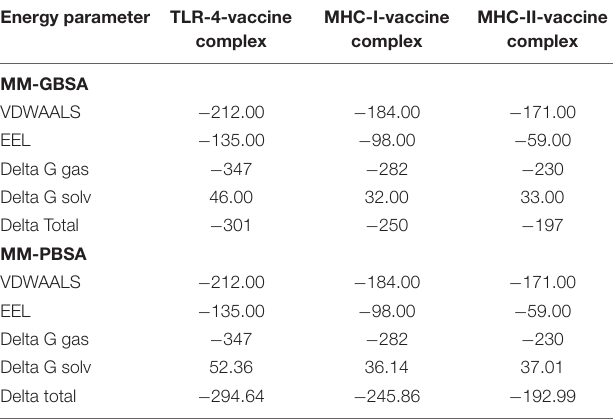
TABLE 7 | Binding free energies of complexes analyzed with MM-GBSA/MM-PBSA methods.